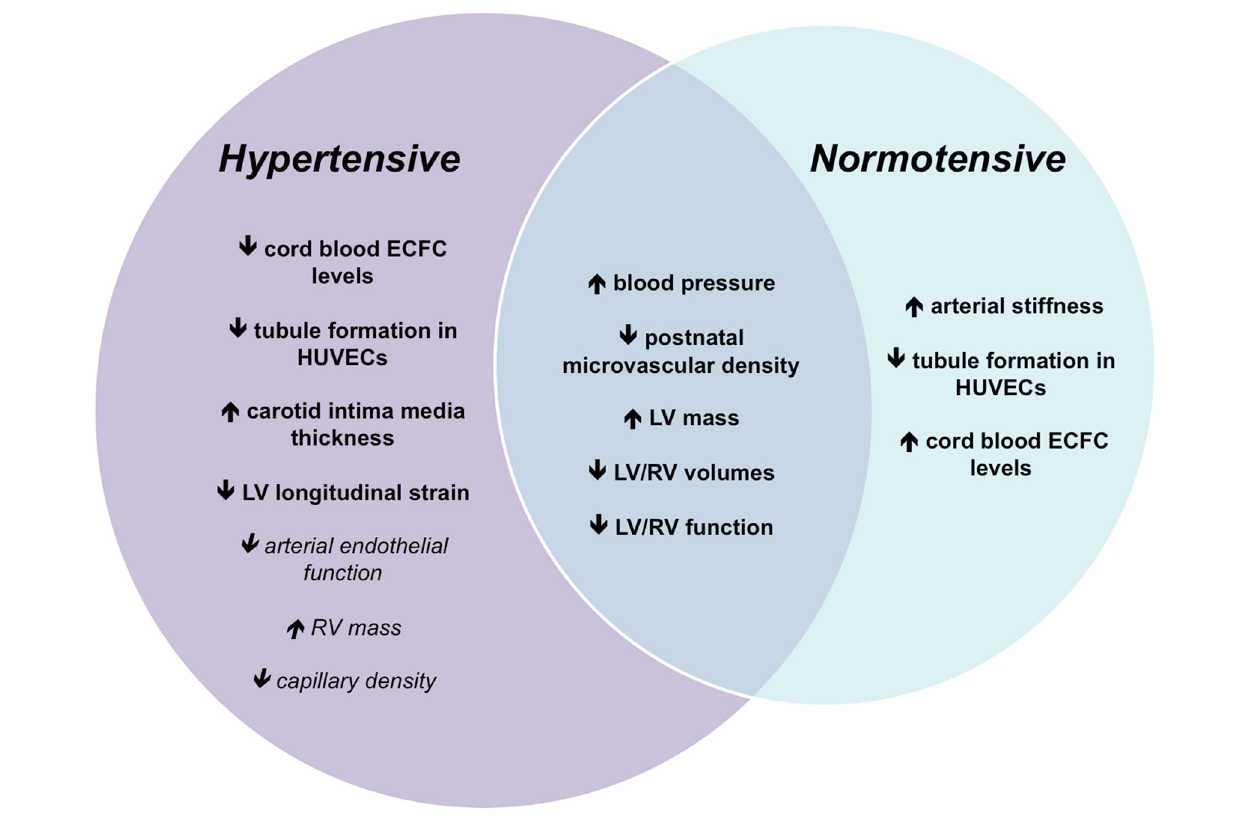
FIGURE 1 | Venn diagram showing the unique cardiac and vascular changes in offspring born preterm to normotensive and hypertensive pregnancies. All characteristics described differ from those born at term to normotensive pregnancies. Changes shown in the middle of the Venn diagram are not distinguishable between the offspring born preterm to normotensive and hypertensive pregnancies. Changes on the left are additional changes seen in the offspring born preterm to hypertensive pregnancies, and those on the right are additional changes seen in the offspring born preterm to normotensive pregnancies. Characteristics on the left that are italicized and not in bold are inconclusive and require further investigation. ECFC, endothelial colony-forming cell; HUVEC, human umbilical vein endothelial cell; LV, left ventricle; RV, right ventricle.